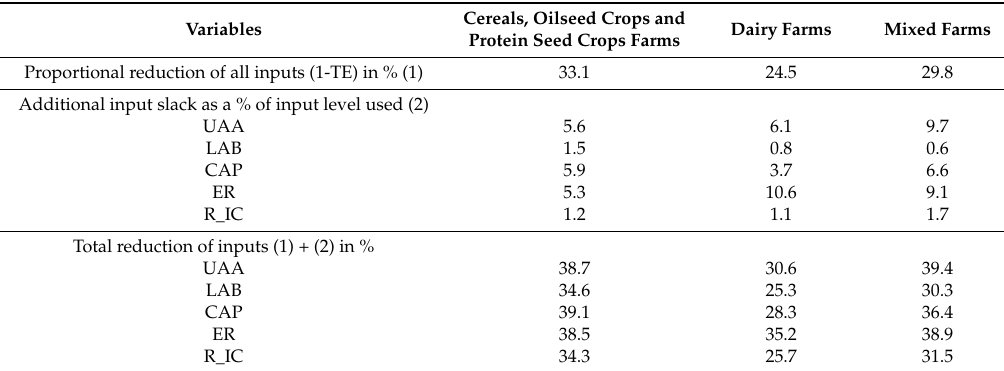
Table 8. Percentage of potential reduction of inputs under technology T2 (averages).